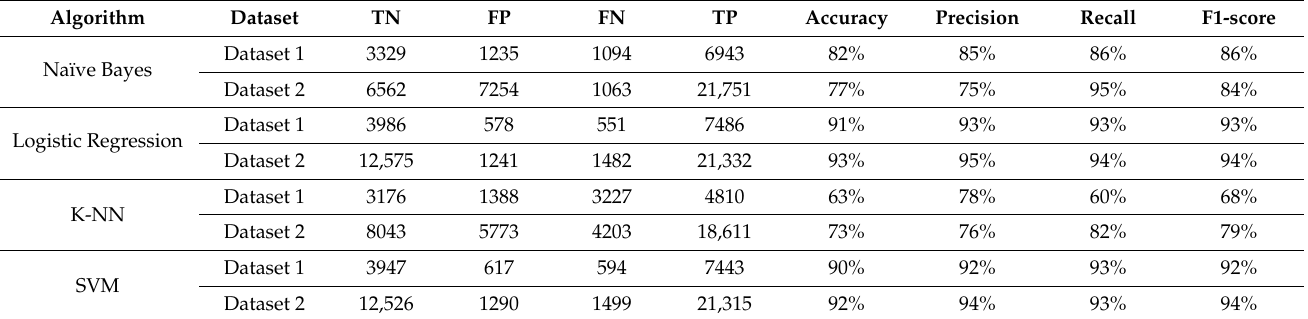
Table 5. Summary of results after initial